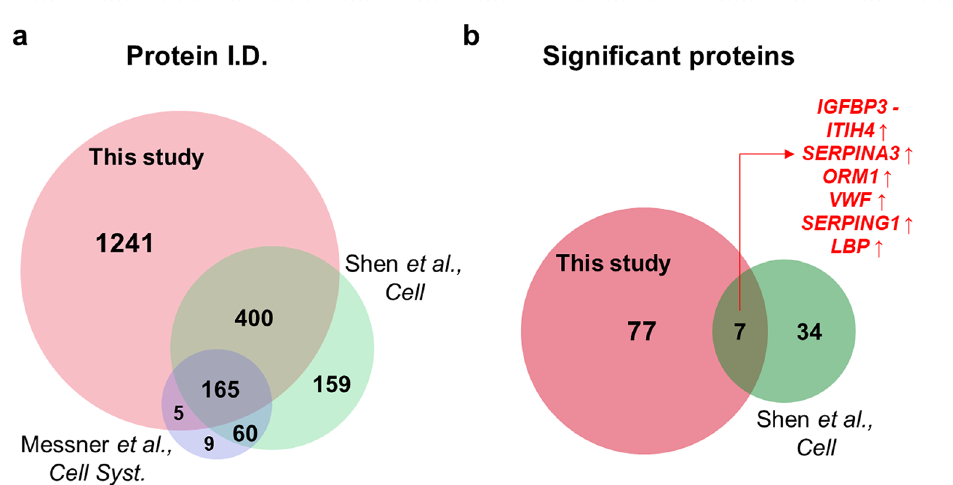
Figure 3. Comparison with other SARS-CoV-2 blood proteome datasets. ( a ) The list of protein identification in our data is compared to that of previously published papers (Shen et al., 2020, Cell and Messner et al., 2020, Cell systems). The protein accession numbers were transformed to gene symbol. ( b ) The significant proteins proposed in two datasets (ours and Shen et al., 2020, Cell) were compared. Seven proteins including IGFBP3, ITIH4, SERPINA3, ORM1, VWF, SERPING1, and LBP were commonly reported as